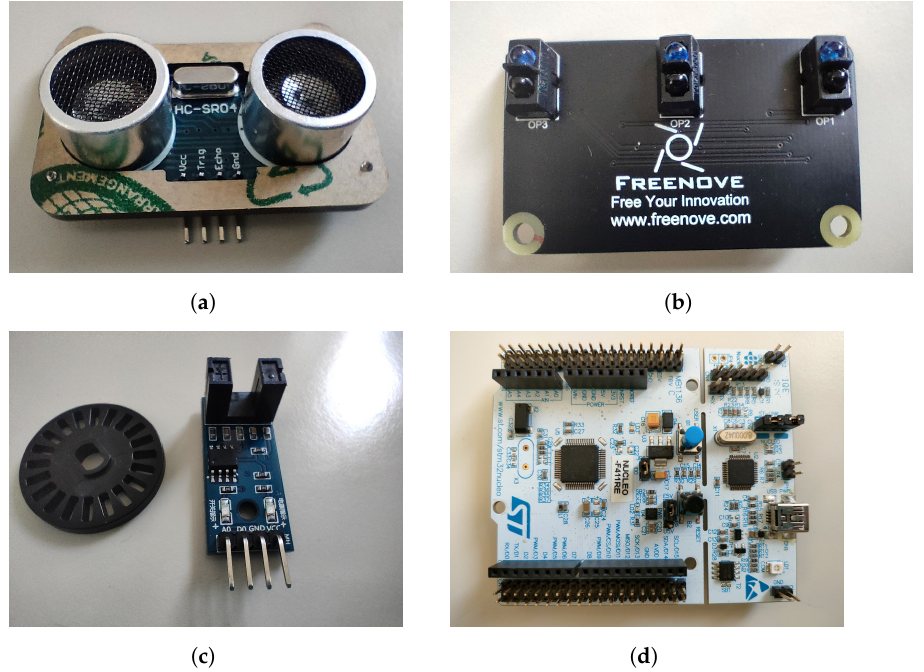
Figure 3. Main components of the minicar. ( a ) Ultrasonic sensor HC-SR04. ( b ) Line-Tracking sensor from Freenove. ( c ) Wheel encoder on the rear wheels to measure the speed. ( d ) Nucleo F411RE Board with microcontroller.